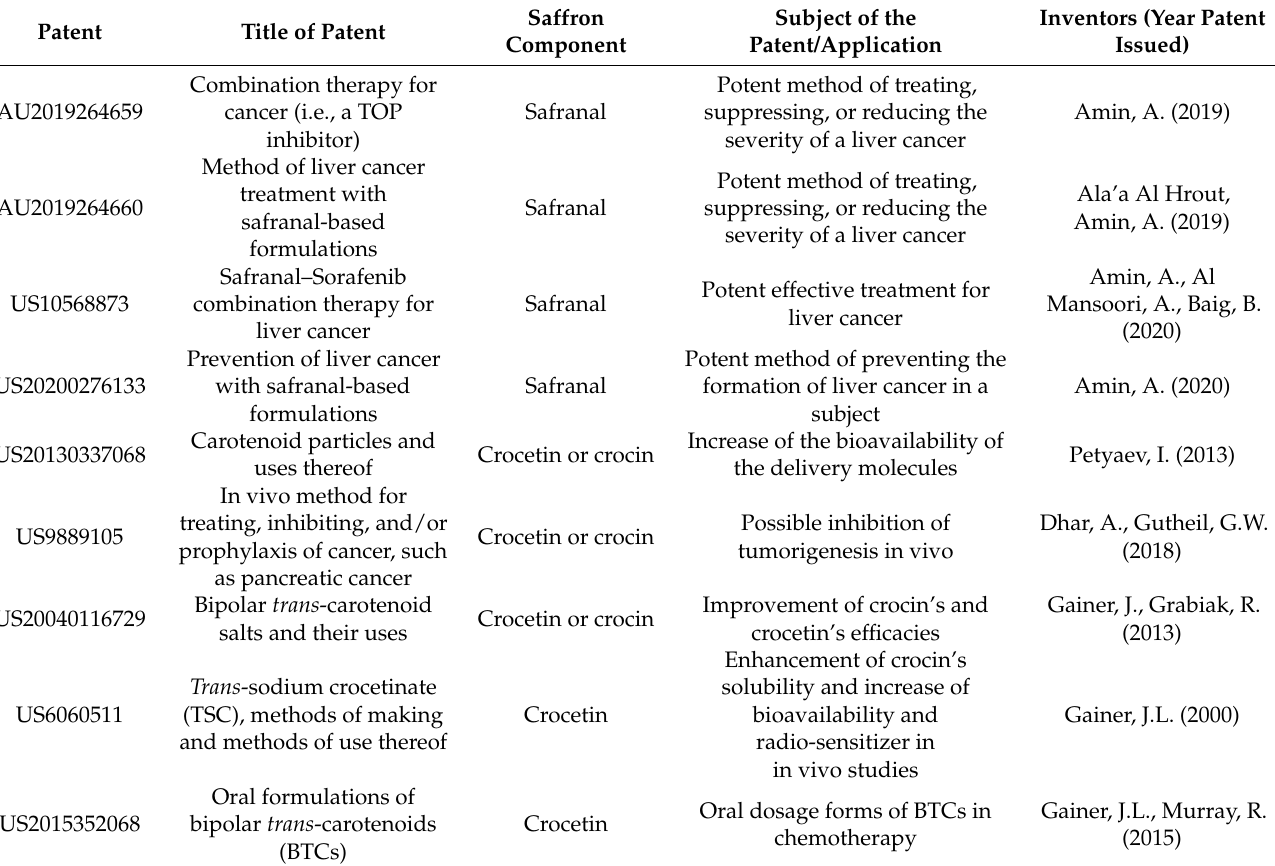
Table 2. Patents based on saffron and its major ingredients and their intended